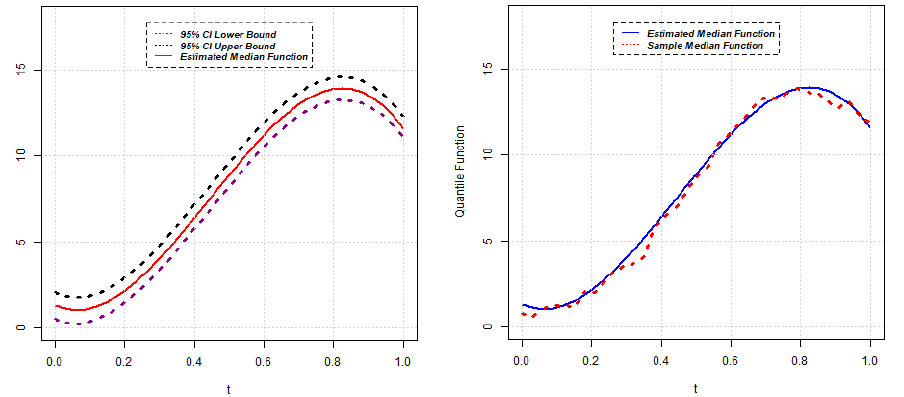
Figure 5. Estimated median function and C.I. ( left ); Estimated median and sample median ( right ) for Model